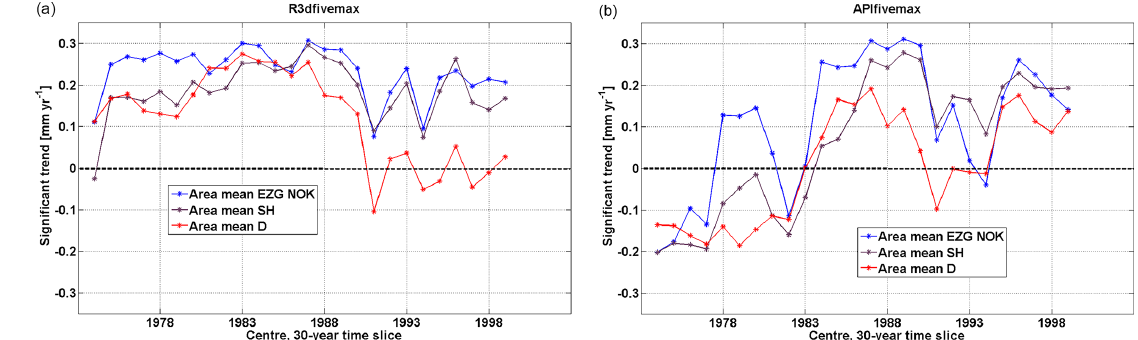
Figure 10. Mean significant trends (above 95% significance level) over 30-year running intervals from 1960–1989 to 1985–2014 in mil- limetres per year for the five highest (a) 3-day event precipitation (R3dfivemax) and (b) antecedent precipitation indices (APIfivemax) per year for the Kiel Canal catchment (blue), Schleswig-Holstein (mauve), and all of Germany (red). The centre year of the respective 30-year time slices is marked on the x axis.